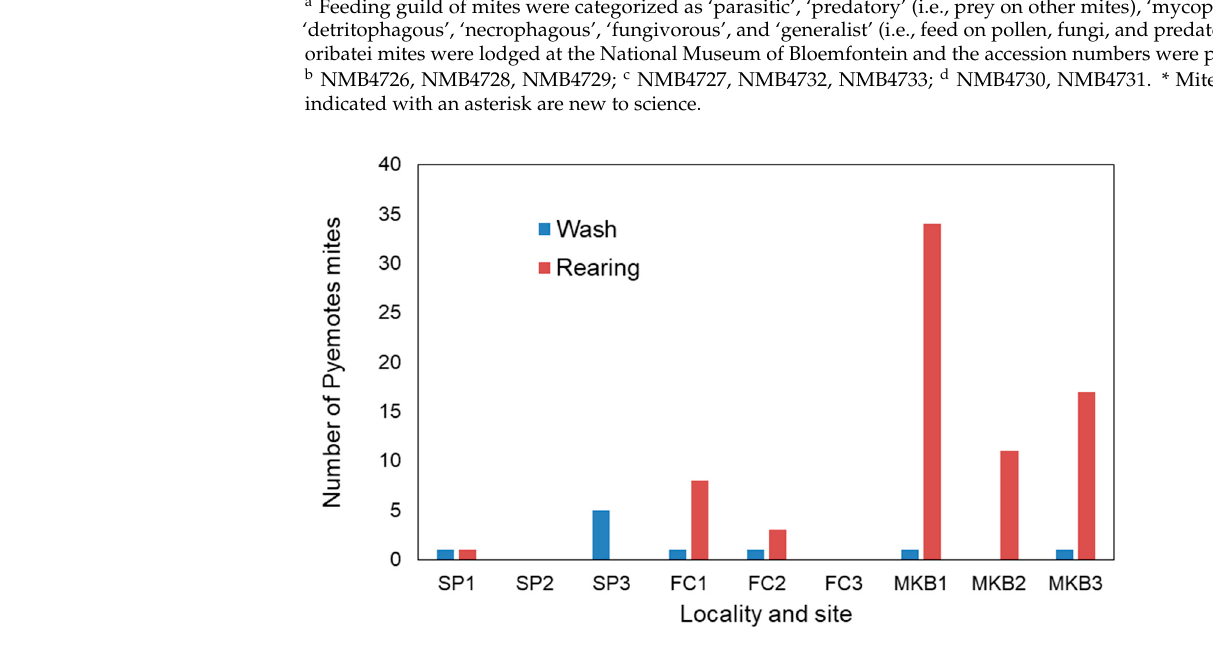
Figure 2. Number of Pyemotes cf. ventricosus mites counted and sites of sample localities, comparing the ethanol wash and gall rearing method (see Materials and Methods). Table 1. Native mite species extracted from Dasineura dielsi galls collected from Acacia cyclops trees in the Western Cape of South Africa. These mite species were recovered from both rearing cages and the ethanol wash experiment. Feeding guild was assigned based on published literature where possible. Table 2. Mite community data matrix (sampling sites by species abundance) across feeding guilds and locations situated in the Western Cape, South Africa. Columns labelled, “Sampling sites” indicate total captures per mite species for the ethanol wash experiment. Any additional mite specimens retrieved from the rearing experiments were indicated in brackets. SP—Shelly Point; FC—Fransmanshoek Conservancy;